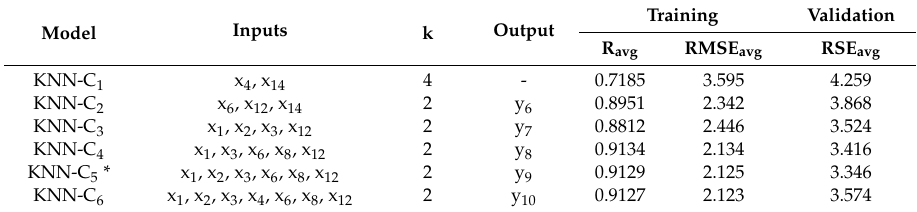
Table 2. Select kNN models using Chebychev distance